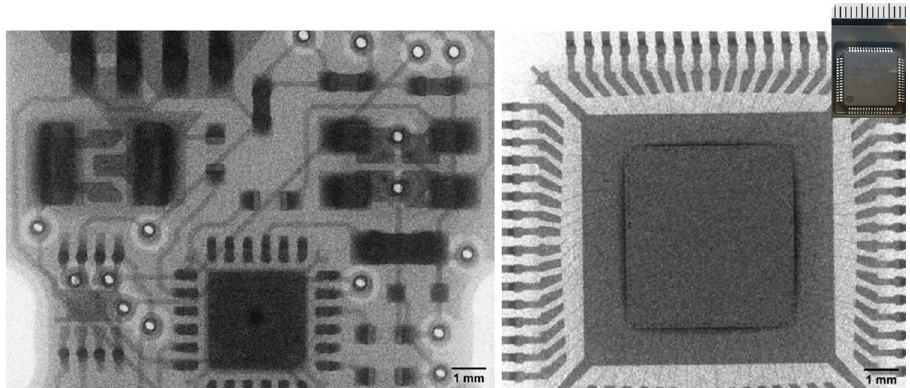
Figure 7. X-ray images of an USB-drive circuit and a microchip. The inset shows the physical mm-scale